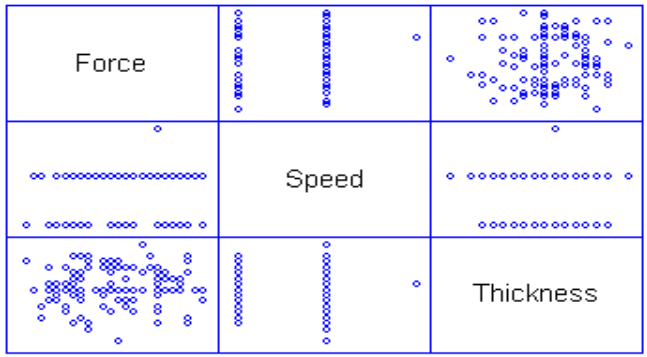
Figure 37. “Scatter plot for force, speed and thickness”.